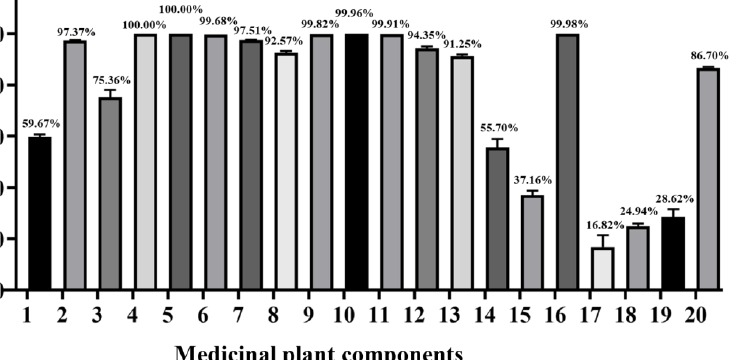
Figure 6. Inhibitory percentage of medicinal plant components against SGIV infection analyzed by Q2-AHTS ( a ) and RT-qPCR ( b ).